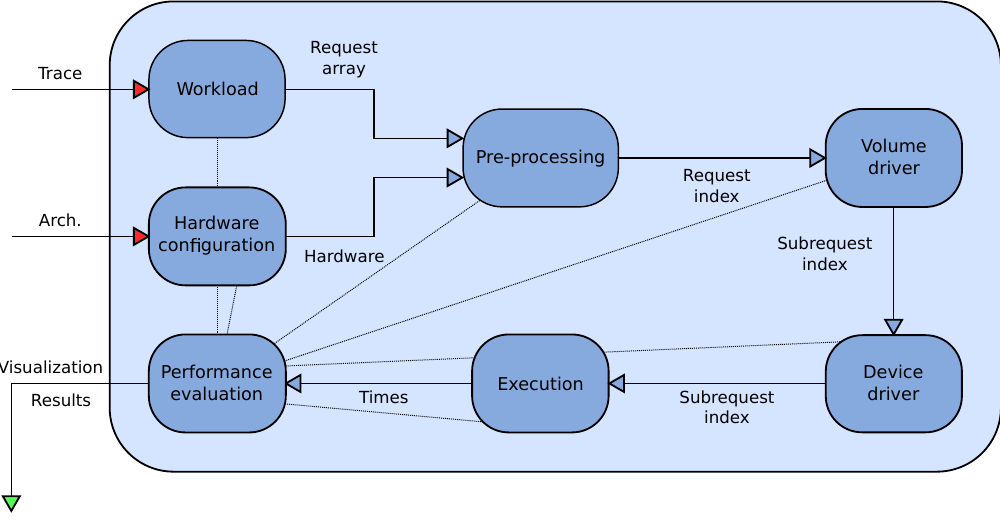
Figure 1: OGSSim design